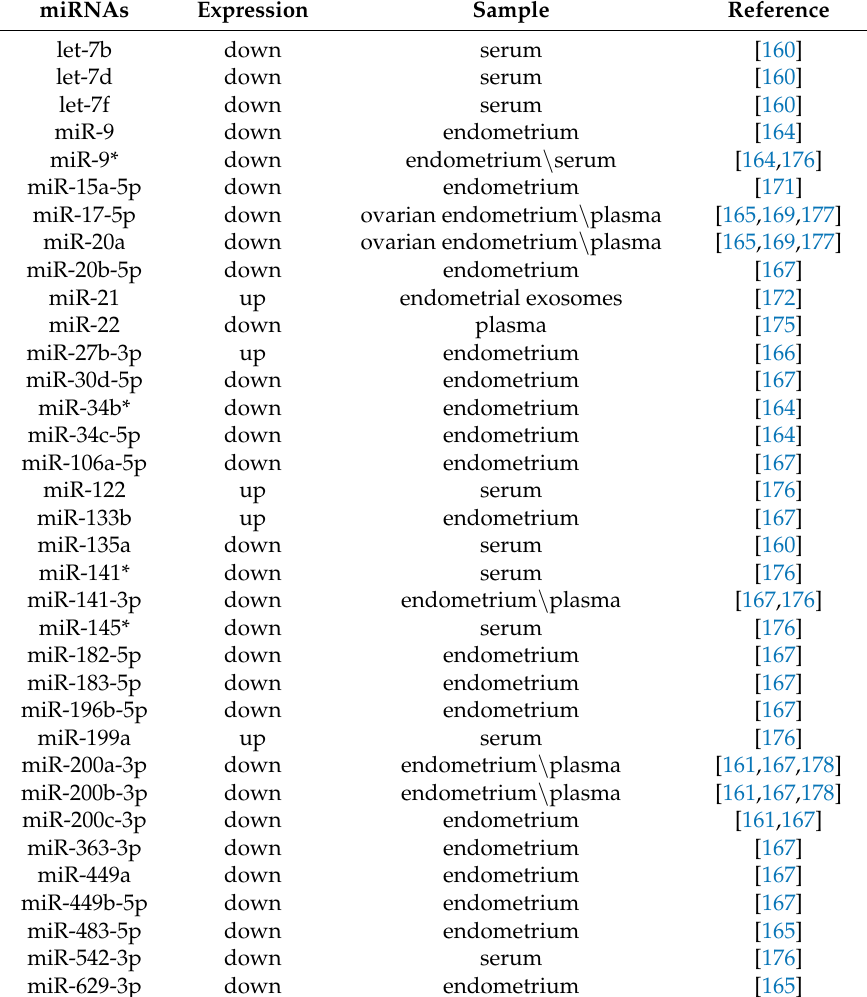
Table 4. miRNAs differentially expressed in Endometriosis